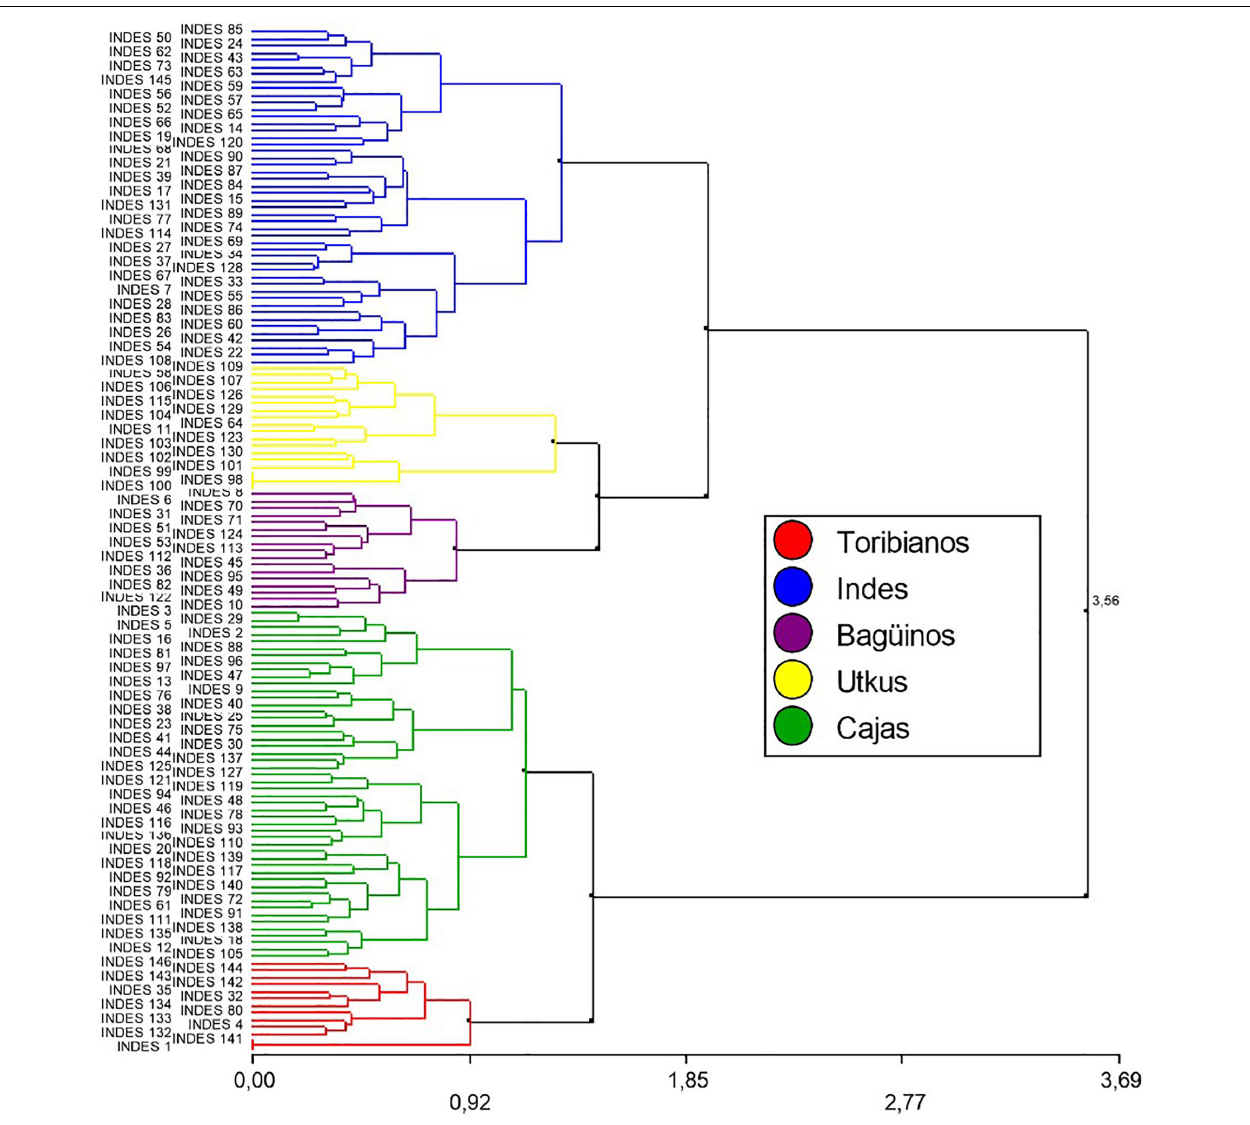
FIGURE 2 | Dendrogram resulting from cluster analysis with Ward’s method (1.35: 5 Groups) and Gower’s distance for 146 FFNC ecotypes based on the profile of their morphological characteristics of the pod and seed, productivity descriptors, and sensory characteristics of cocoa beans.